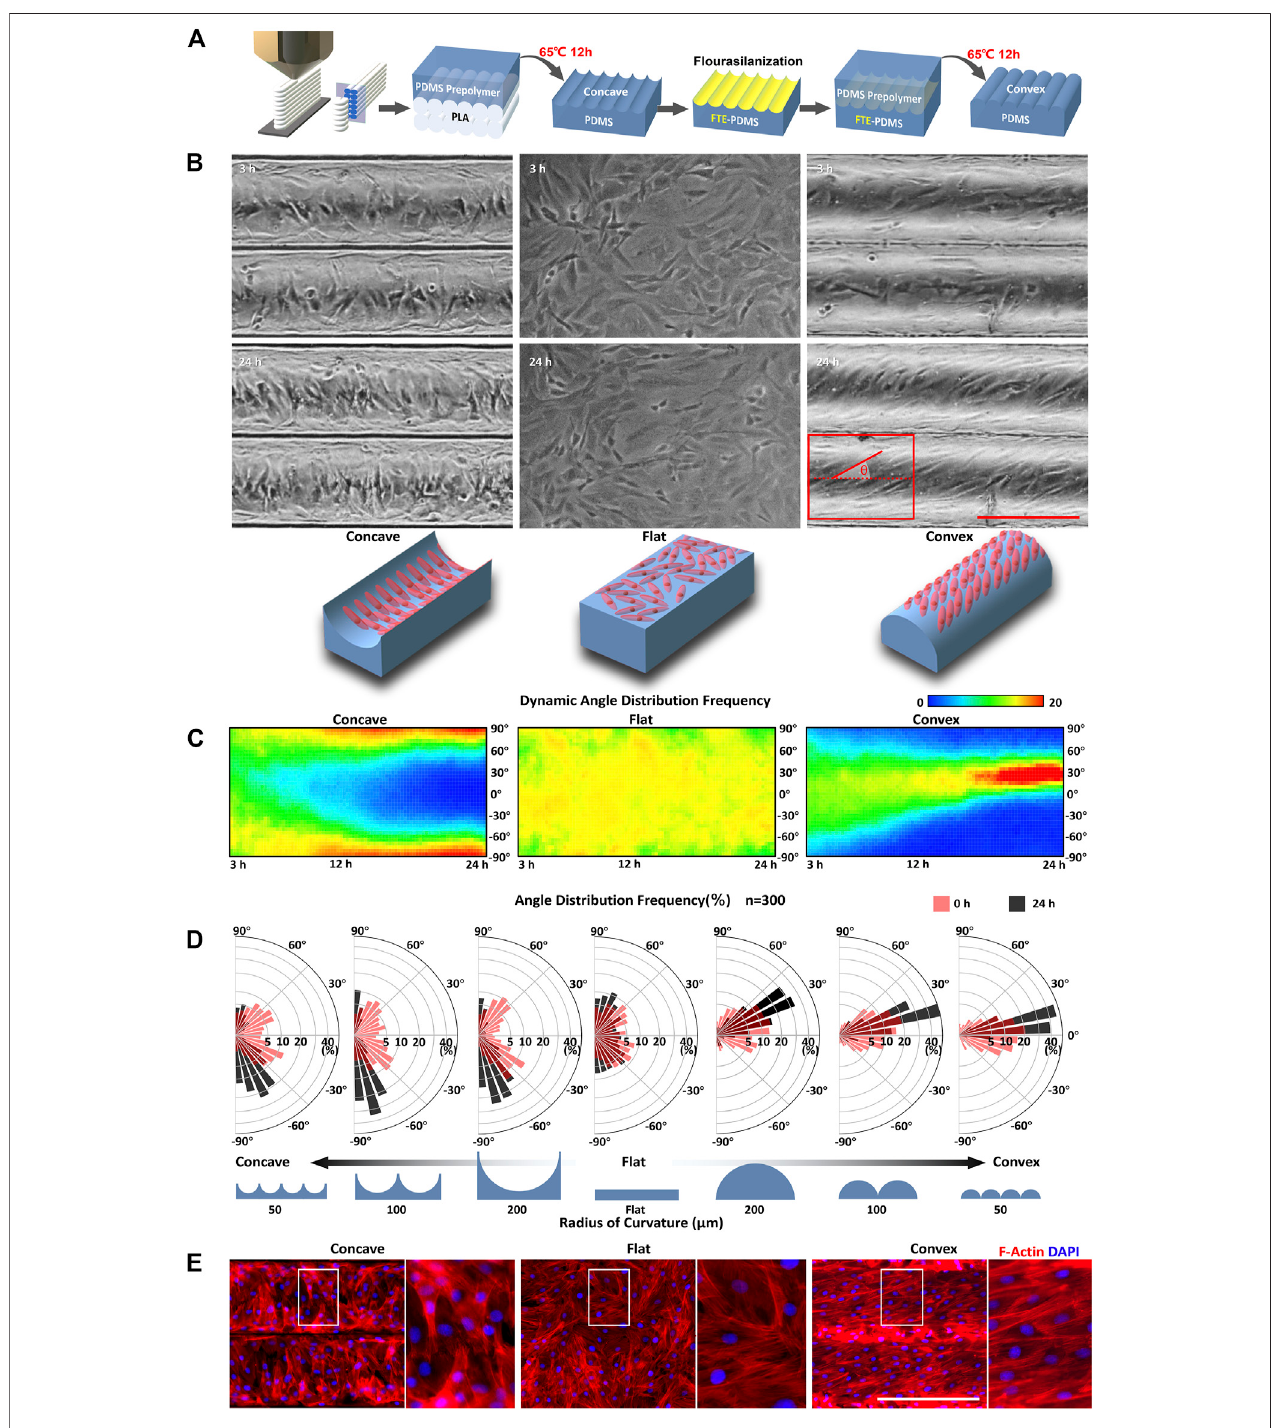
FIGURE 1 | Curvature-driven differential self-organization of ASMCs (A) Setup used to fabricate cell culture chips with concave and convex surface substrate (B) Representative phase contrast images of ASMCs cultured on a concave surface ( R (cid:1) 100 μ m; left panel), fl at surface (middle panel), and convex surface ( R (cid:1) 100 μ m; right panel) for 3 and 24 h, respectively, and schematic representation of the observed cell orientation in corresponding concave, fl at, and convex surfaces (bottom panel), scale bar (cid:1) 200 μ m (C) The thermal diagram shows dynamic orientation of the cells on different curved surfaces from 3 to 24 h, where the color represents thefrequencyofcellsdistributedinanangularinterval(stepsize (cid:1) 5 ° ).Thebiasedangleofcellorientationwasde fi nedastheanglebetweenthelong(principal)axisofthe cell and the cylinder axis as shown in the red diagram in (B) (D) Angular histograms showing the quantitative data of biased angle distribution of the ASMCs on concave andconvexsurfaceswithdifferentradiiofcurvature,anda fl atsurfacefor3 h(red)and24 h(black).Dataofthefrequencyofbiasedanglecalculatedfrom300cellsinone experiment that is representative of three independent experiments (E) Representative immunostaining images of F-actin (red) and nuclei (blue) for ASMCs on concave ( R (cid:1) 100 μ m), fl at, and convex ( R (cid:1) 100 μ m) surfaces. Scale bar (cid:1) 200 μ m.